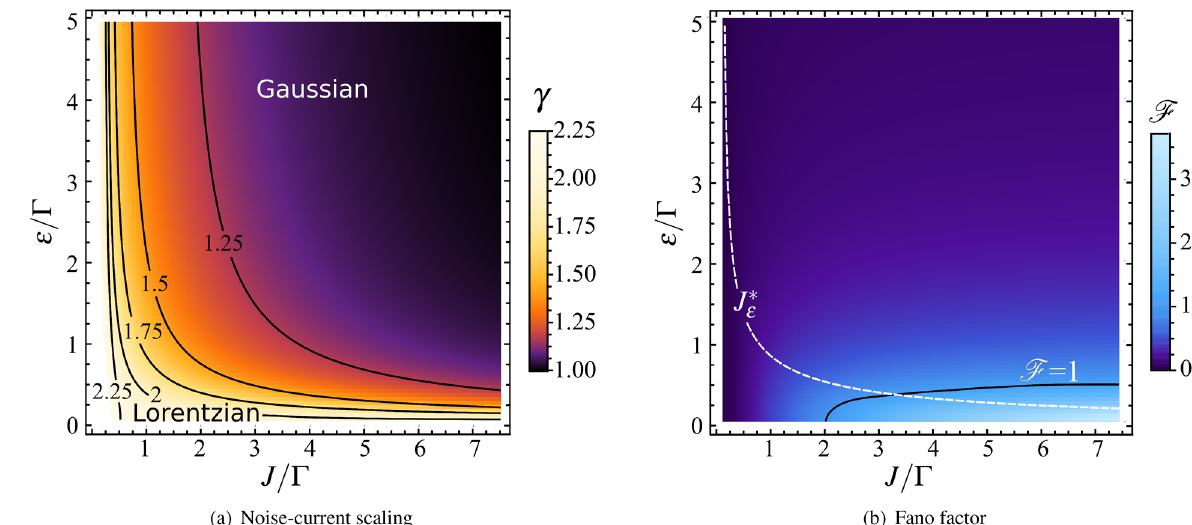
J γ as functions of the photon current ∝ d ln S γ show a d ln J . Contours of constant = 2 , and the Gaussian is to many-body transport and = 3 / 2 asymptotic appears at low currents and large anharmonicity ε/Ŵ > 1 . = F 1 S / J . The white dashed curve is J ∗ ε . The black solid line stands for = =